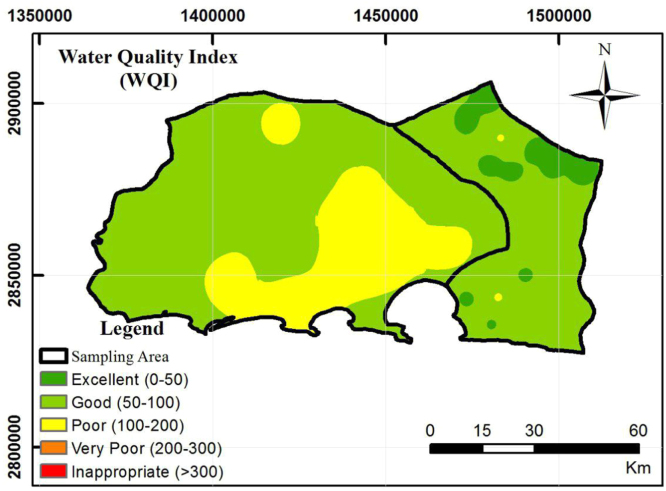
Spatial distribution map of water quality index.